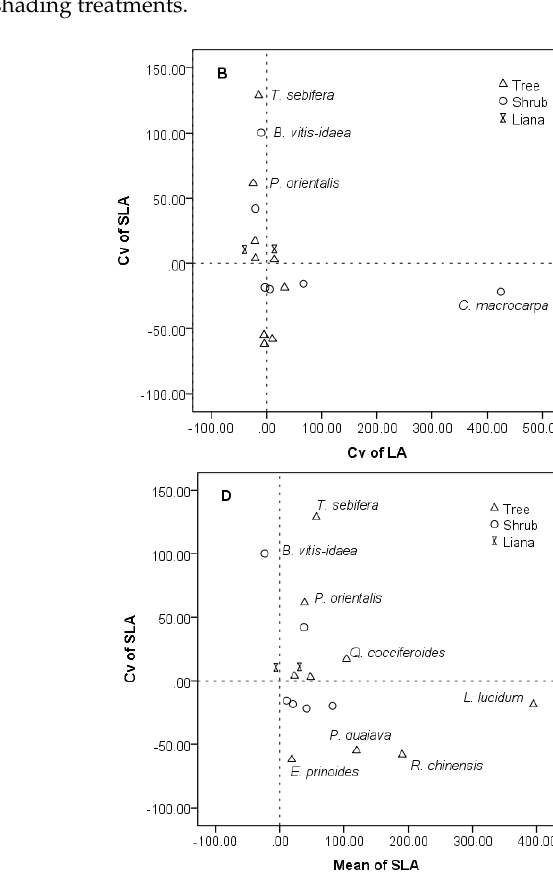
Figure 4. The distribution of variation coefficients of leaf traits in different populations at different shading gradients. Each circle presents a value for a different species, and the dotted line presents the changes in the mean of the overall species. All species that were studied in the communities ( A ) and the same species in the four treatments ( B ) were analyzed. Different letters indicate significant differences among the four shading treatments.